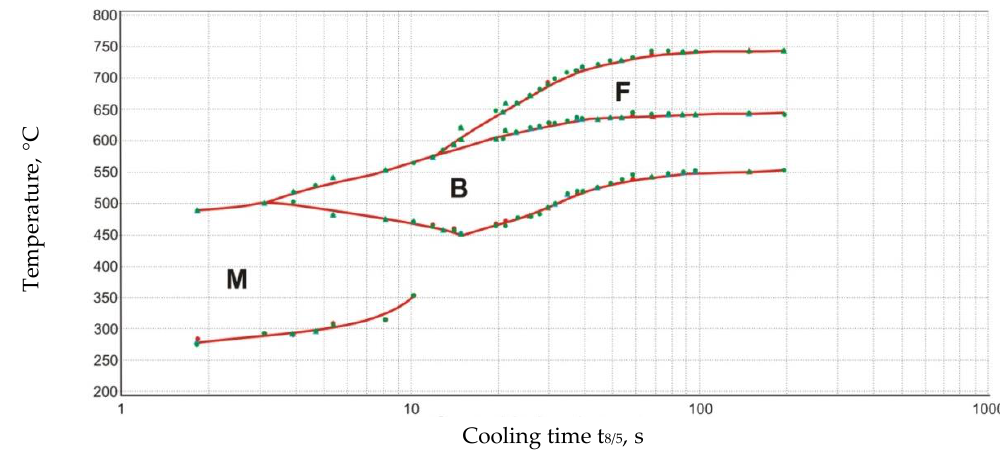
Figure 3. CCT diagram of the S700MC steel.